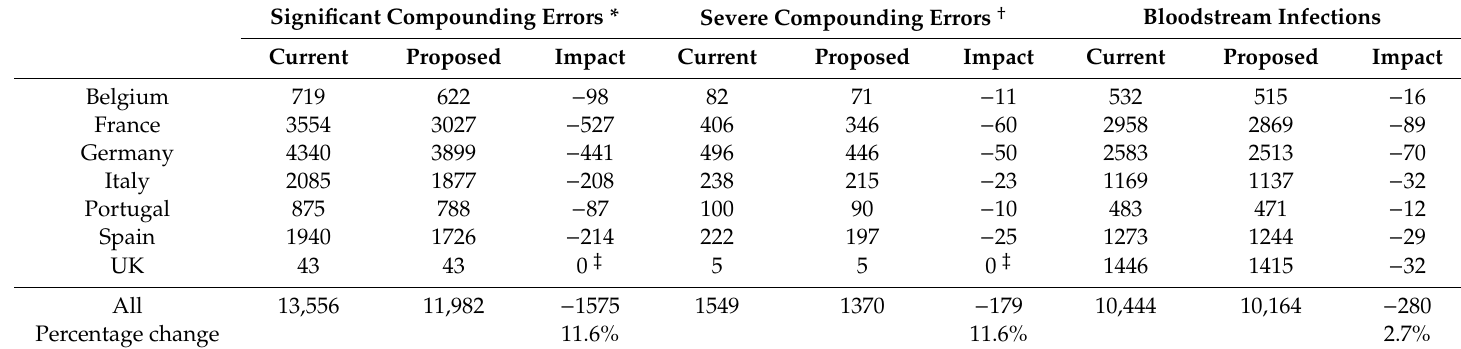
Table 2. Estimated national clinical implications of a 10-percentage point increase in ready-to-use